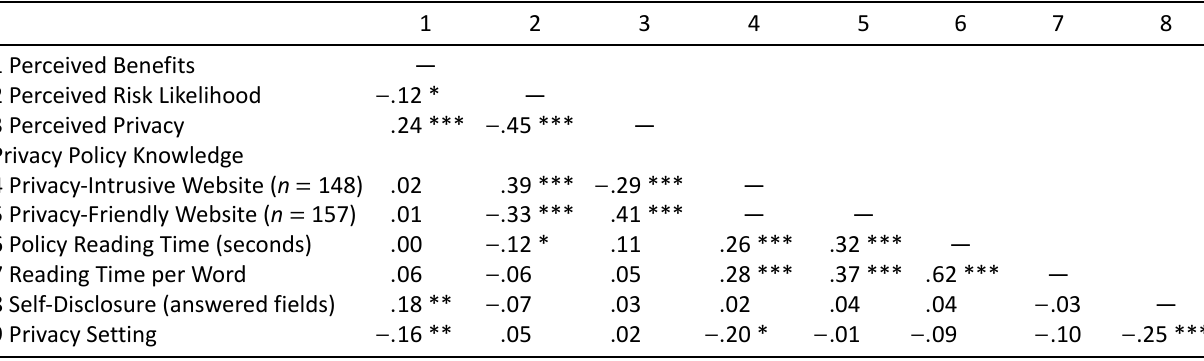
Table 3. Bivariate correlations between all assessed constructs and behavioral